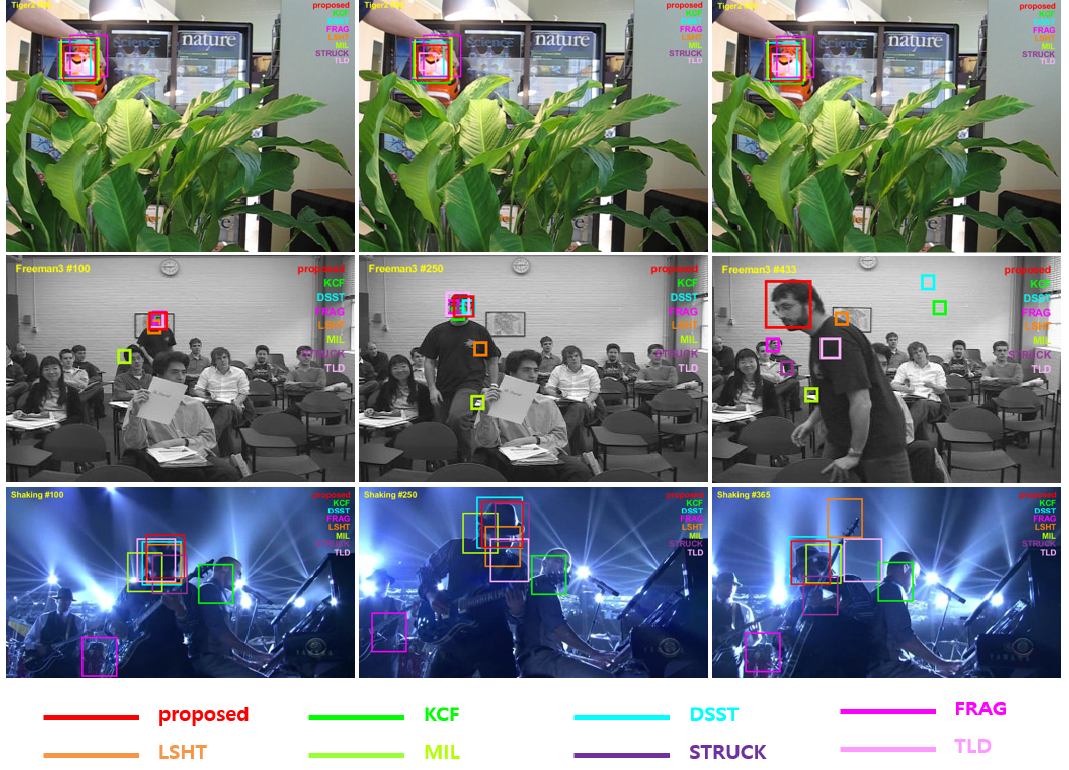
Figure 1. Comparison of the proposed method with the state-of-the-art trackers kernelized correlation filter (KCF) [21], discriminative scale space tracker (DSST) [22], fragment-based tracker (FRAG) [15], locality sensitive histograms tracker (LSHT) [37], multiple instance learning (MIL) [6], structured output tracking with kernels (STRUCK) [5] and tracking-learning-detection (TLD) [9]. The sequences include Tiger2, Freeman3 and Shaking from